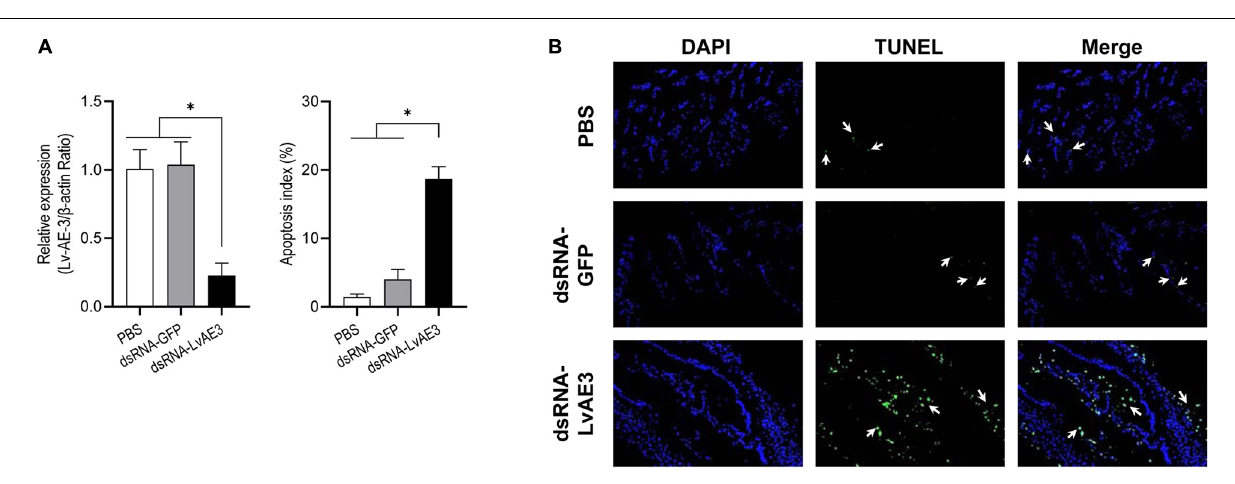
FIGURE 7 | (A) Silencing efficiencies of Lv-AE3 in the shrimp gill. The data are presented as the mean ± SE ( n = 5), and the significances of p < 0.05, 0.01, and 0.001 are indicated with *, **, and ***, respectively. (B) Apoptosis analysis of L. vannamei gill after knockdown of Lv-AE3 . The apoptotic cells are indicated by the